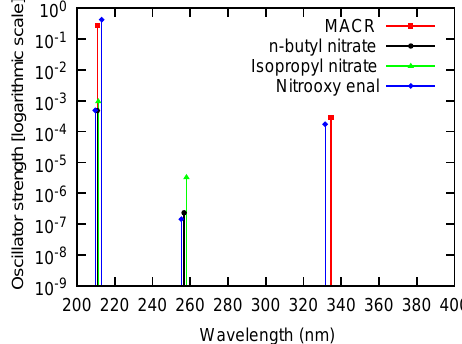
Figure 4. Theoretical gas-phase absorption spectra of the nitrooxy enal, MACR, isopropyl nitrate, and n -butyl nitrate in the gas